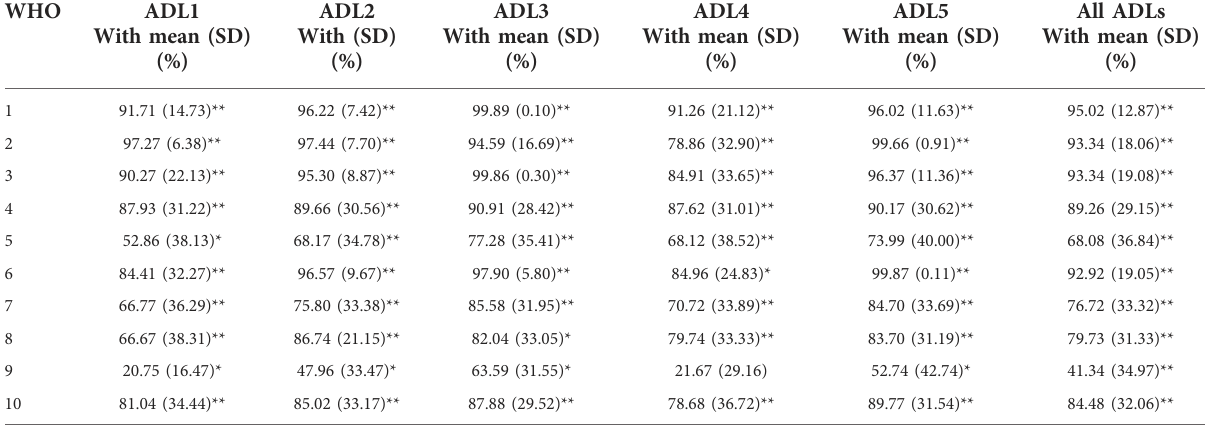
TABLE 6 Percentage of time that the wrist was in radial deviation throughout each ADL by each WHO. WHO